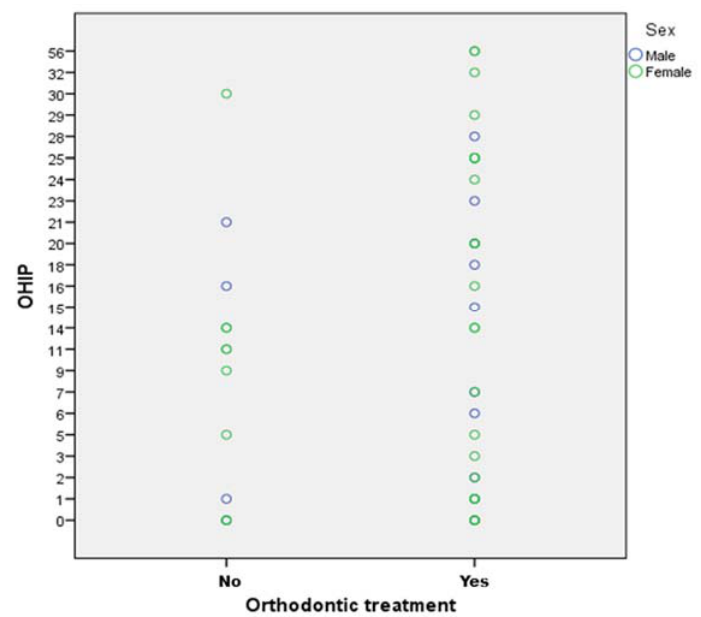
Figure 1. OHIP (Oral Health Impact Profile) values for “non-orthodontically treated” and “orthodontically treated”